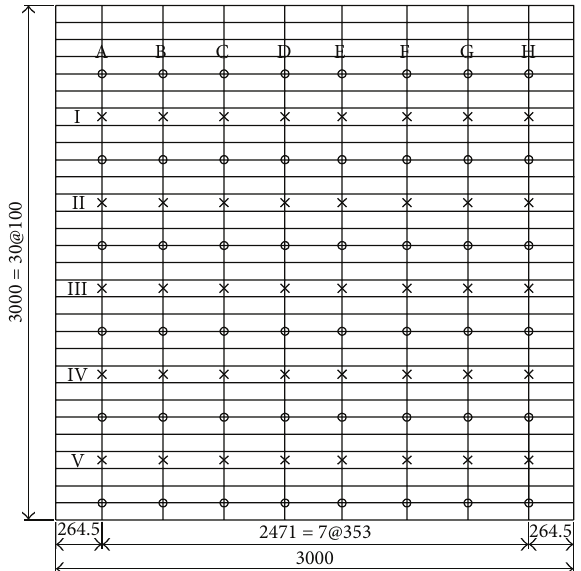
Figure 9: A plan view of the 353 × 100 mm test point grid for the P-wave measurement. The test was carried out on the grid locations. The ∘ (circle) and × (cross mark) indicate the positions of the transducers and average measurements, respectively.